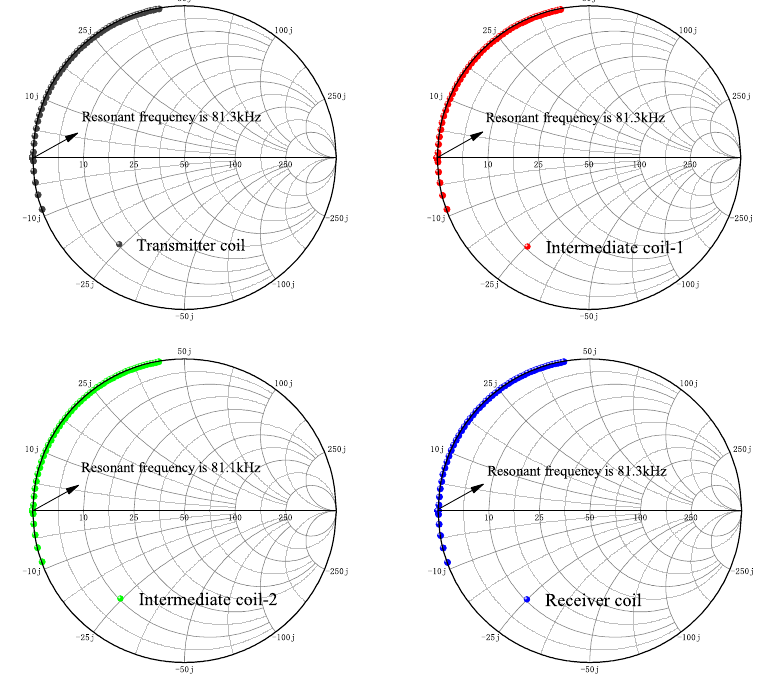
Figure 9. The Smith chart of each resonant circuit in the range of 50 KHz–400 KHz.